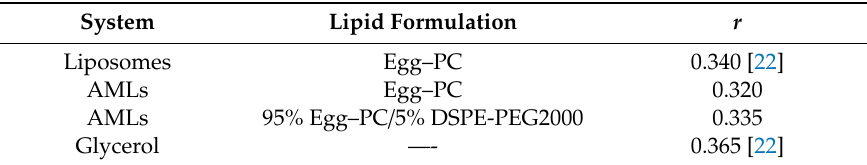
Table 4. Steady-state fluorescence anisotropy ( r ) values for curcumin at 25 ◦ C in aqueous magnetoliposomes containing Ca 0.25 Mg 0.75 Fe 2 O 4 . Values for curcumin in liposomes and glycerol are shown for comparison. System Lipid Formulation r Liposomes Egg–PC 0.340 [22] AMLs Egg–PC 0.320 AMLs 95% Egg–PC / 5% DSPE-PEG2000 0.335 Glycerol —- 0.365 [22]